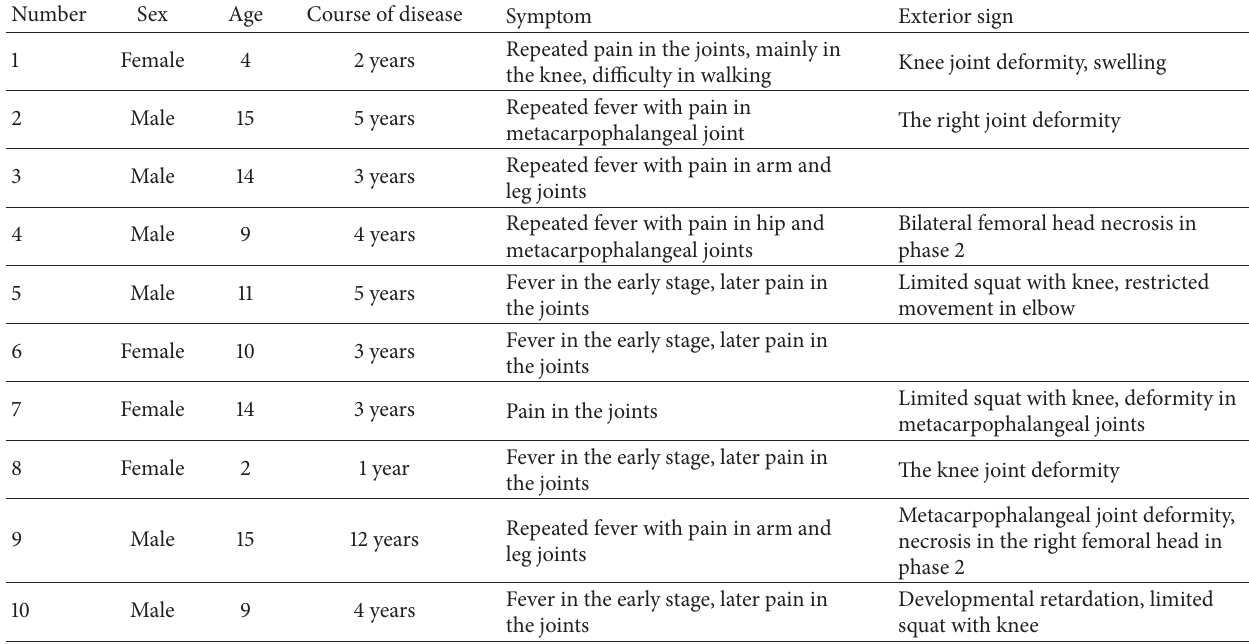
Table 1: List of patient